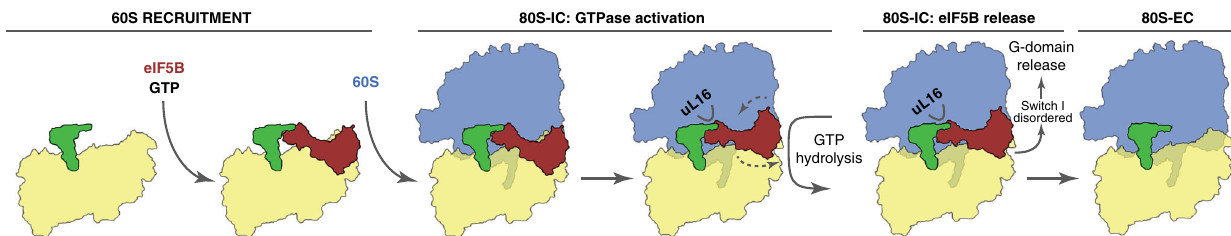
Fig. 6 A structural view of the on-ribosome eIF5B catalysis. After Met-tRNA i Met (green) is delivered to the P site of the small subunit (40S, yellow) and the start codon is recognized, eIF5B in its GTP-bound form is able to transiently stabilize the aminoacyl-tRNA in the P site and catalyze the recruitment of the large subunit (60S, blue). Proper positioning of Met-tRNA i Met , eIF5B, and the 60S would lead to the structuring of the uL16 loop (residues 100 –